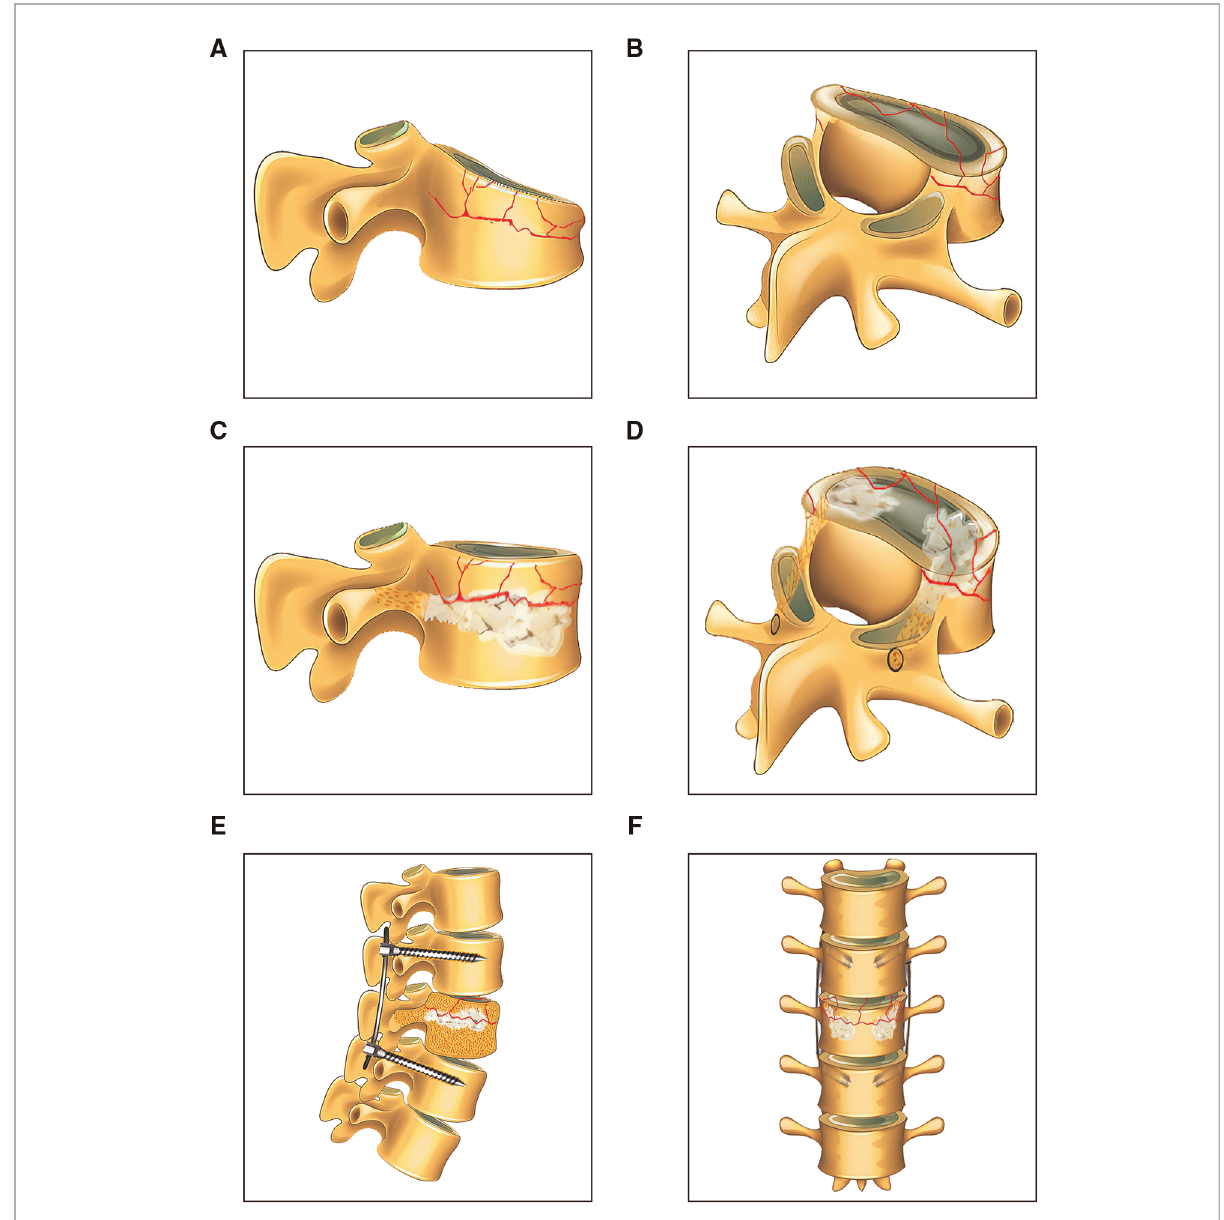
FIGURE 2 The simulation diagram of treatment outcomes in patients who underwent PPSR. ( A,B ) The preoperative sagittal and oblique diagram of the fractured vertebra. ( C,D ) The postoperative sagittal and oblique diagram of the vertebra. ( E,F ) The images of postoperative spinal segments in coronal and sagittal